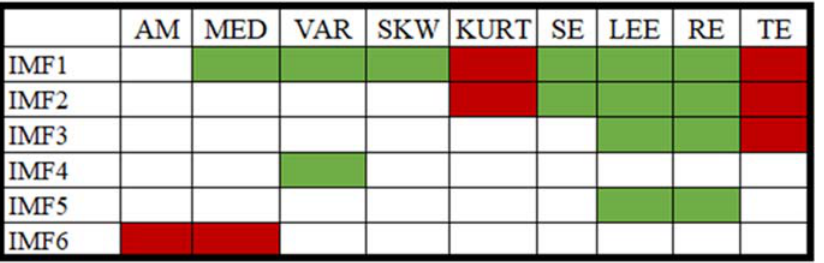
Figure 5. Typical IMFs of a 5 s ECG signal ( a ) before and ( b ) after consumption of coffee.